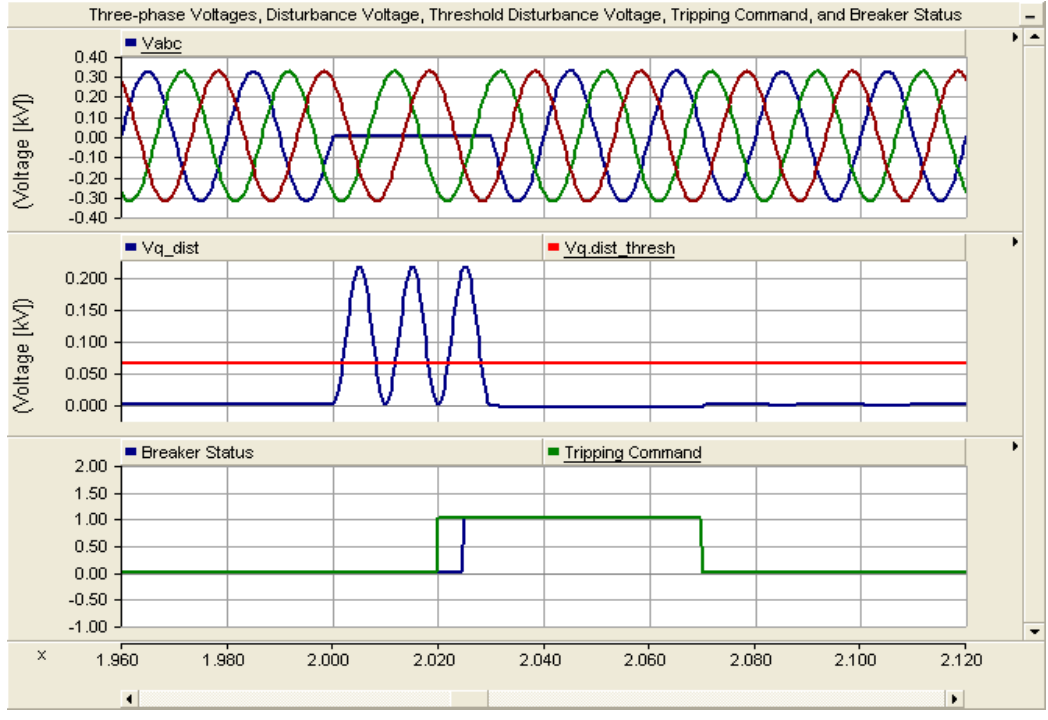
Figure 8. 3-phase voltages, disturbance voltage, and trip signal for F6.